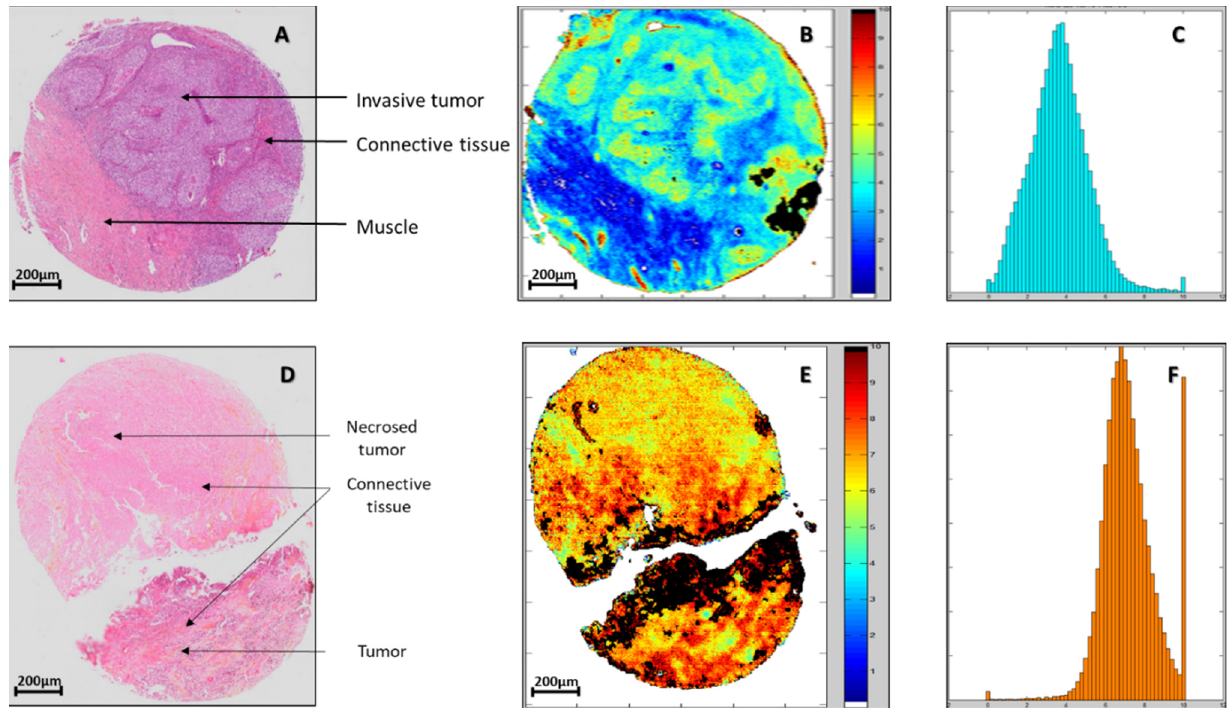
Figure 2. Histology ( A , D ); PLS scoring ( B , E ) and histogram ( C , F ) of test samples from one NR (up) and one R (down) patients. The histograms indicate the number of pixels as function of the R/NR PLS score.